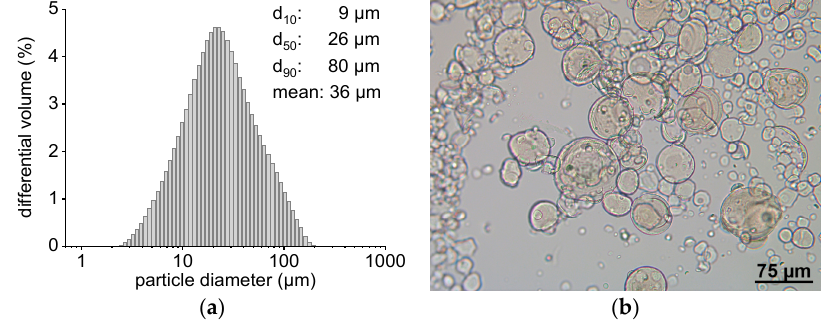
Figure 2. ( a ) Particle size distribution (determined via LD) of an exemplary microsphere batch that was used for fenofibrate transfer. ( b ) Light microscopic image of the same microbeads batch.